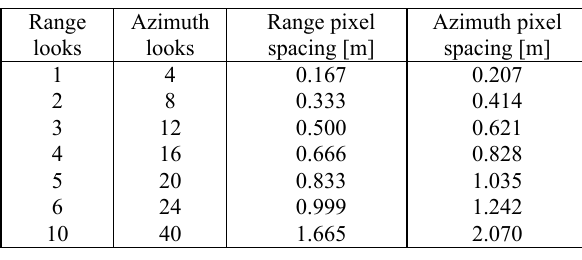
Table 3. Number of looks tested in the interferometric processing. The azimuth pixel spacing corresponds to the average over the 6 tested datasets at Memmingen.